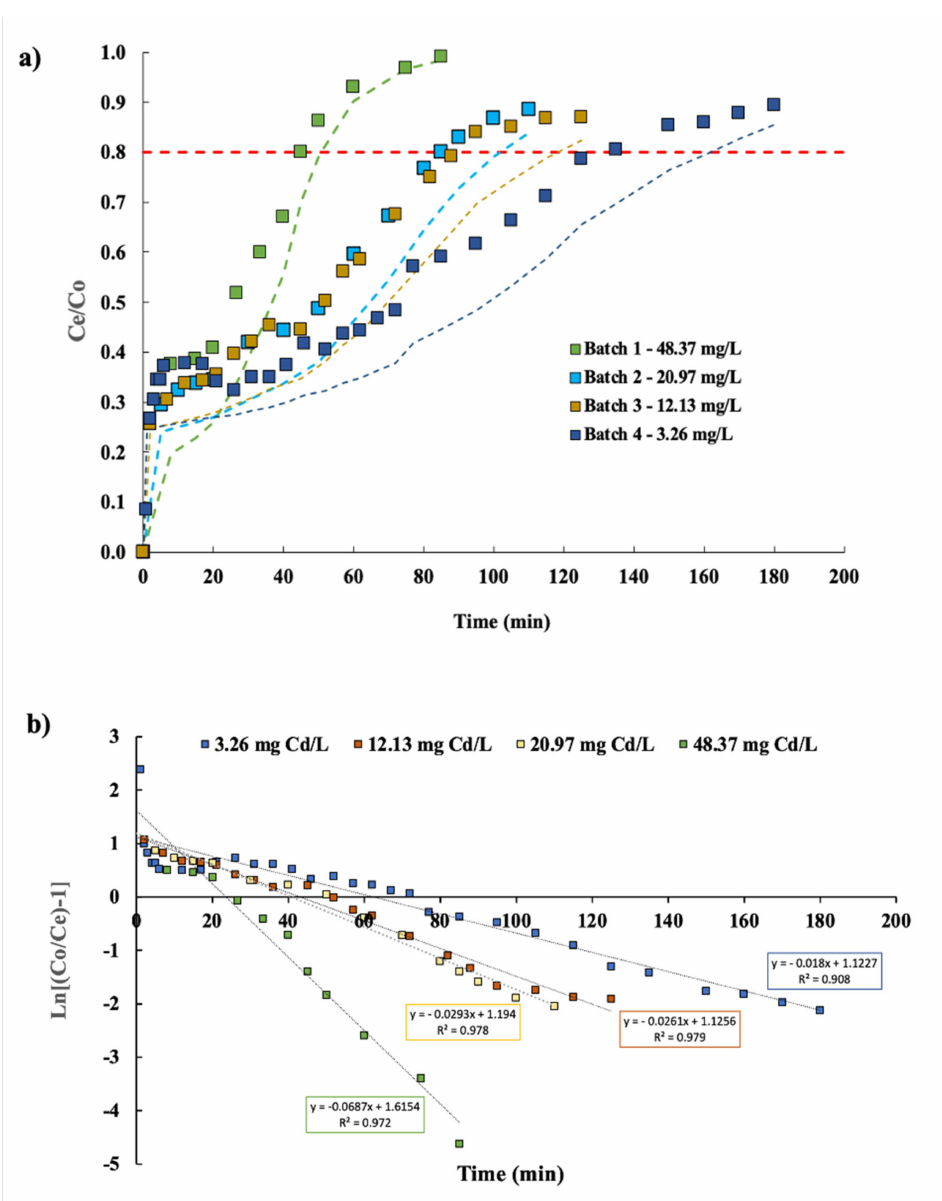
mum adsorption of cadmium (q max ) by the model, where the highest value of cadmium adsorbed onto the resin was for an initial concentration of 48.37 mg L − 1 of cadmium in the GSH solution, with a q total of 1015.3 mg g − 1 and q max of 1137.4 mg g − 1 , thus demonstrating a major affinity of the resin for cadmium at elevated cadmium concentrations in the GSH.